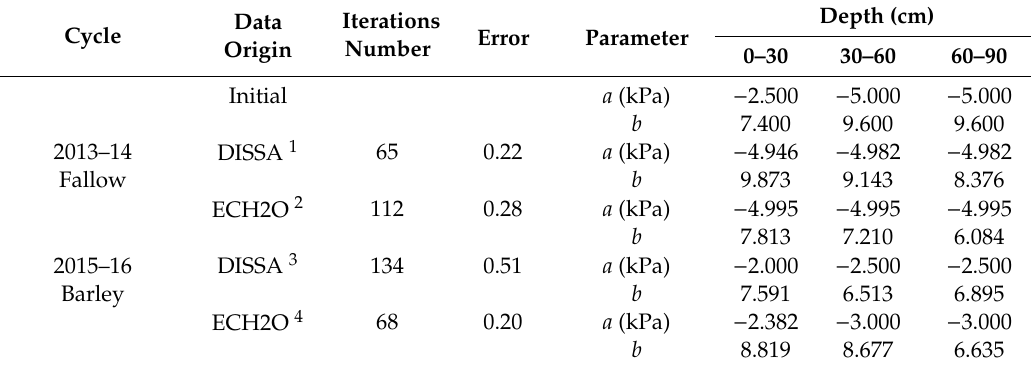
Table 3. Initial and optimal values of the hydraulic parameters adjusted through mathematical iterations for a soil under fallow and under barley cultivation during the seasons 2013 / 14 and 2015 / 16 seasons, respectively, with soil samples (DISSA) and soil moisture sensors